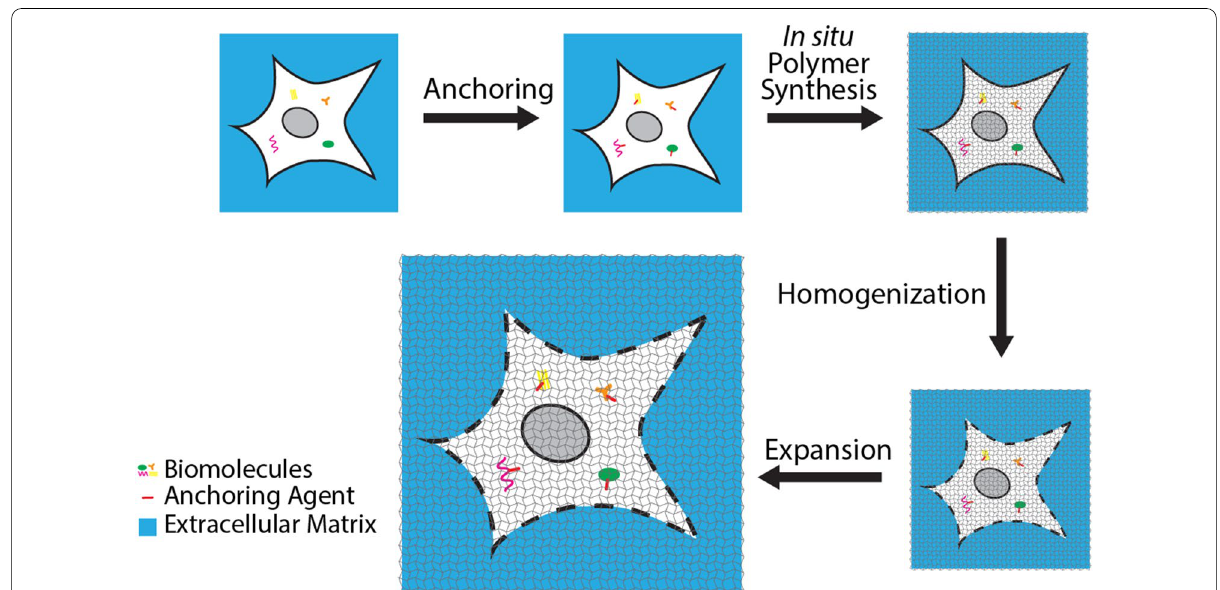
Fig. 2 General workflow of expansion microscopy (ExM). Biological samples are first infused with a chemical anchor and polymerized in situ to form a sample-hydrogel composite. It then goes through a homogenization step, in which the molecules and structures that maintain the mechanical integrity of the sample are broken down. Finally, the sample-hydrogel composite is dialyzed in water for